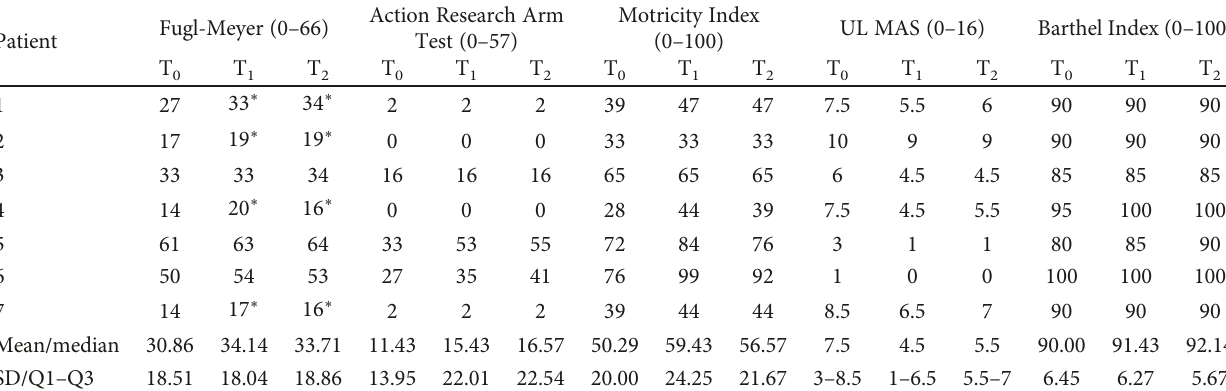
Figure 3: Fugl-Meyer and Modi fi ed Ashworth Scale scores, stroke lesions, and topographic maps showing ERD/ERS values during passive movement of the a ff ected hand are reported for three representative patients (numbers 1, 2, and 4). Blue indicates maximal ERD. BI: bilateral ERD; C: ipsilesional ERD; I: contralesional Table 2: Changes in primary and secondary outcome scores.